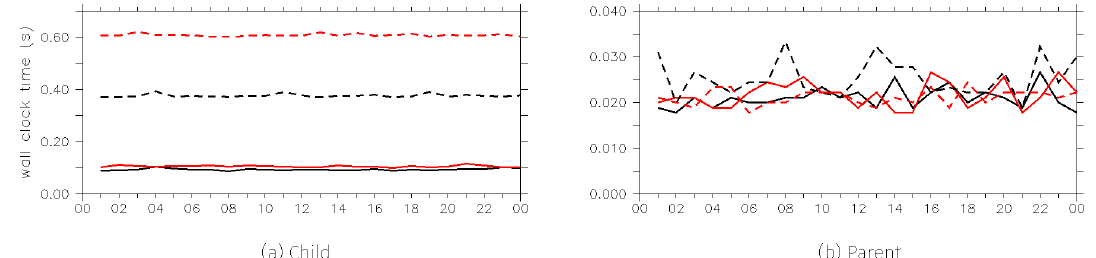
Figure 12. Hourly averaged wall-clock time spent for the processing of the coupling data in the submodels (a) MMD2WAY_CHILD and (b) MMD2WAY_PARENT for a MECO(2) setup, shown for different couplings between the two COSMO/MESSy instances: one-way coupling (black) and two-way dynamical coupling (red). The dashed lines are for the additional coupling of 139